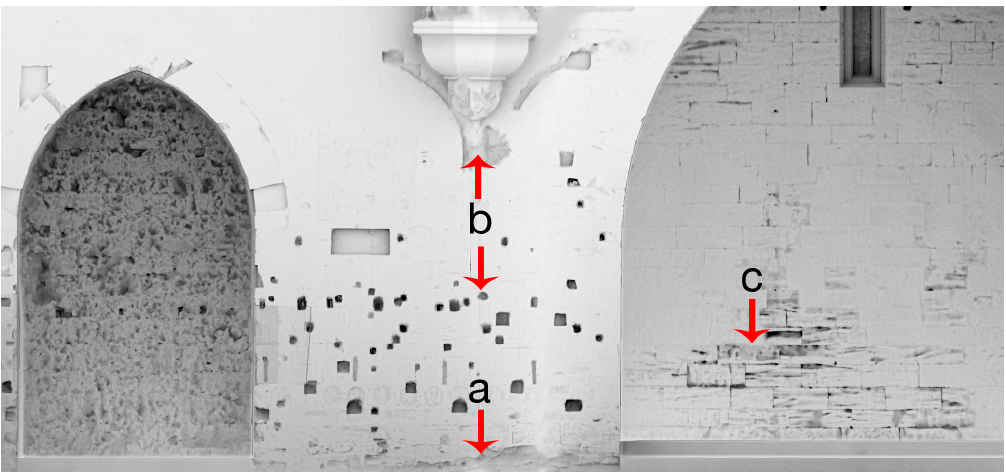
Figure 4. 2D raster from an environmental occlusion generated in 3D: ( a ) loss of material; ( b ) holes and alterations of the stone; and ( c ) disintegration of stone.